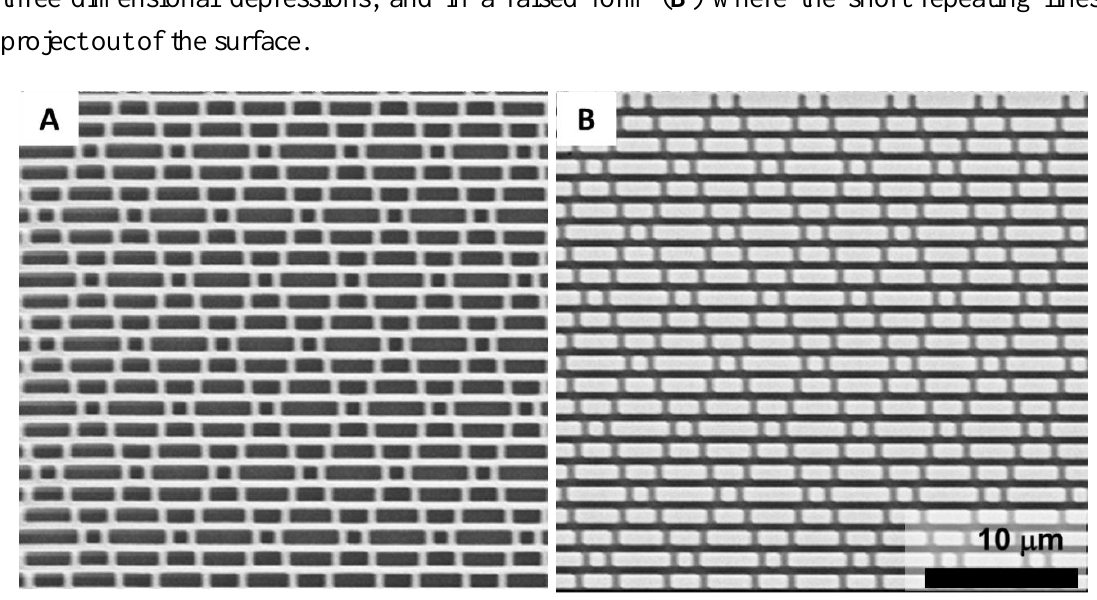
Figure 1. Electron micrographs of engineered topographies for antifouling purposes. A